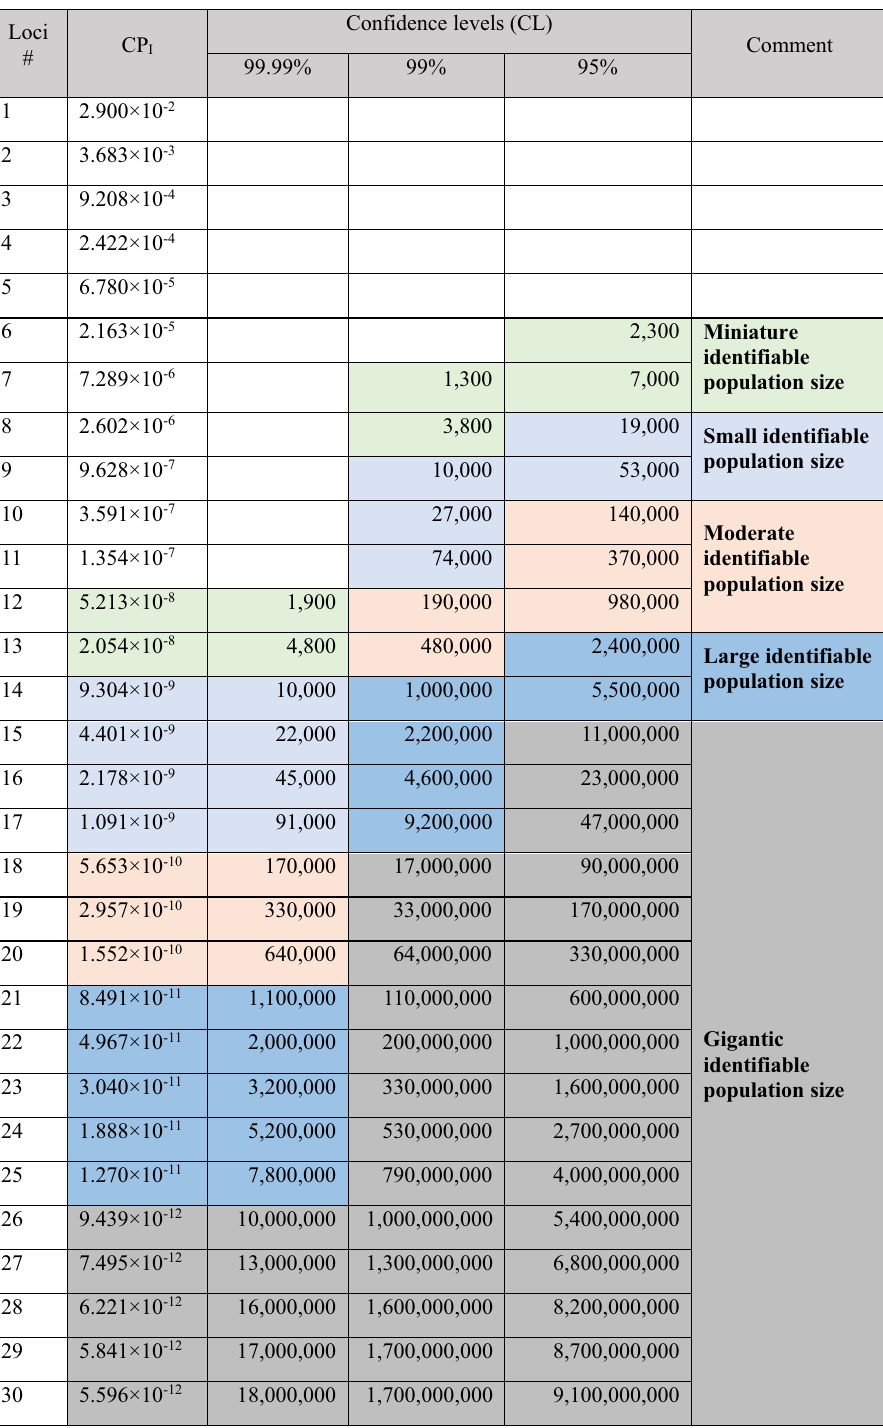
Table 5. The discrimination power in SSR marker combination. CP I cumulative random probability of identity, CL = (1 − CP I ) N , N number of